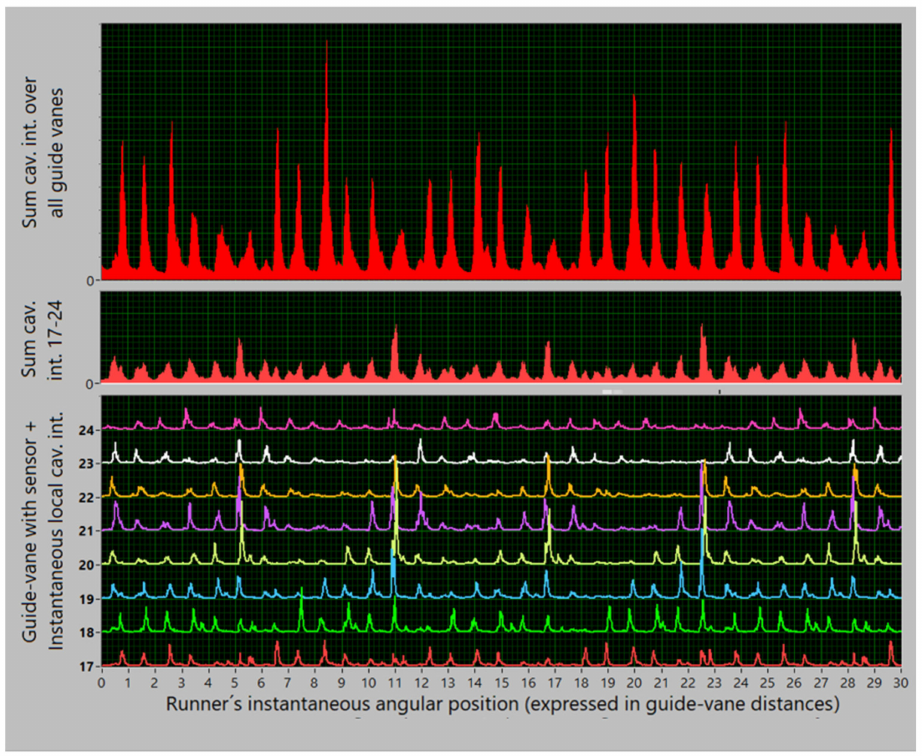
Figure A2. From above: ˆ I sta (